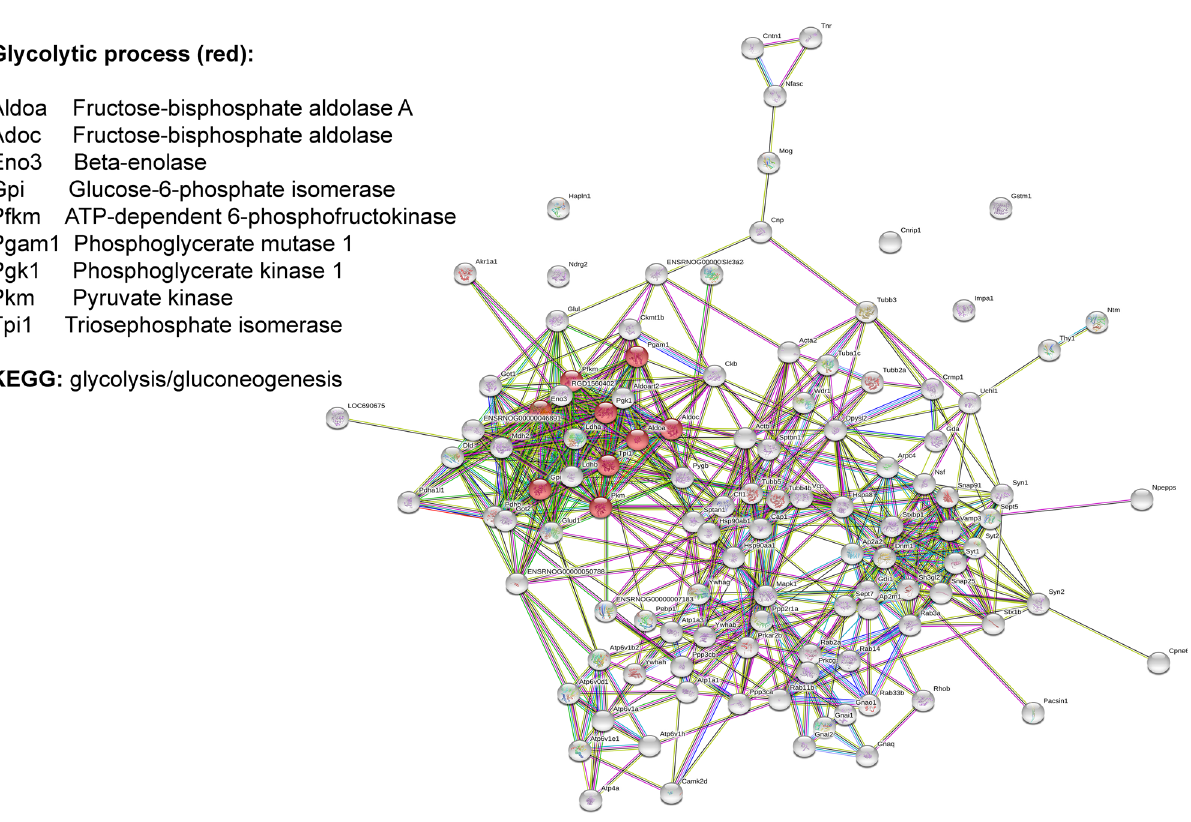
Figure 3. STRING-based interactome map of interactions among differently up-regulated synaptosomal proteins in CSIS vs. Control rats, with the corresponding GO Biological process